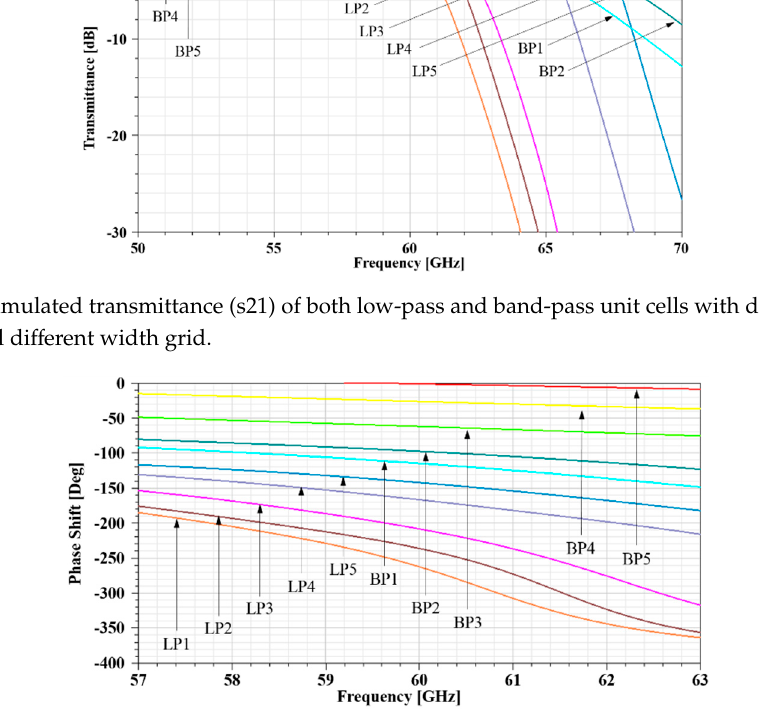
Figure 8. Simulated phase shift of both low-pass and band-pass unit cells with different patch sizes and grid width.